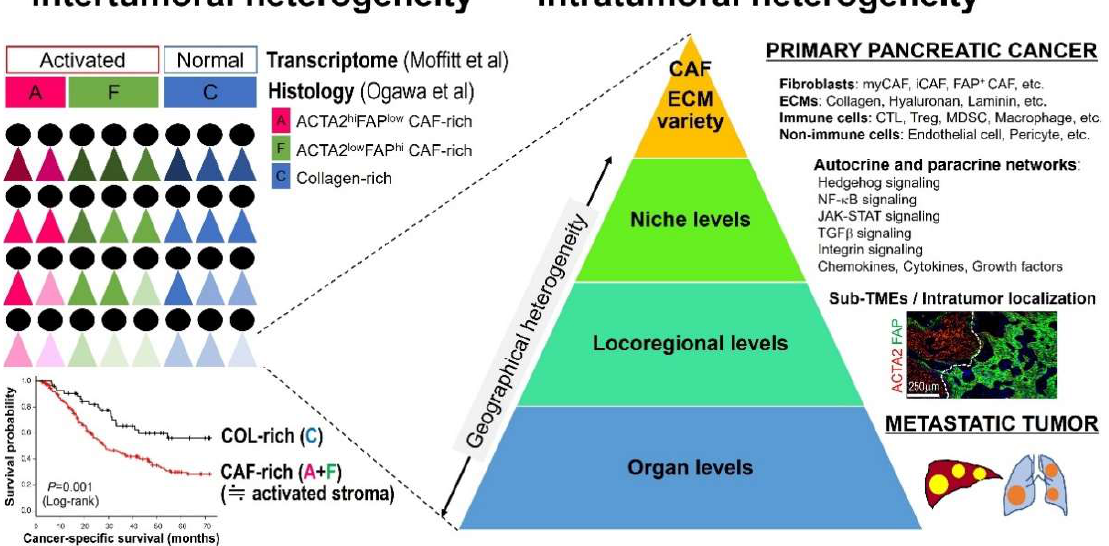
Figure 1. Multilayered levels of pancreatic ductal adenocarcinoma (PDAC) stromal heterogeneity. PDAC desmoplastic stroma is highly heterogenous between patients and even in a tumor at multilayered levels. Abbreviations: CAF, cancer-associated fibroblast; CTL, cytotoxic T cell; ECM, extracellular matrix; iCAF, inflammatory cancer-associated fibroblast; MDSC, myeloid-derived suppressor cell; myCAF, myofibroblast cancer-associated fibroblast; TME, tumor microenvironment; Treg, regulatory T cell.